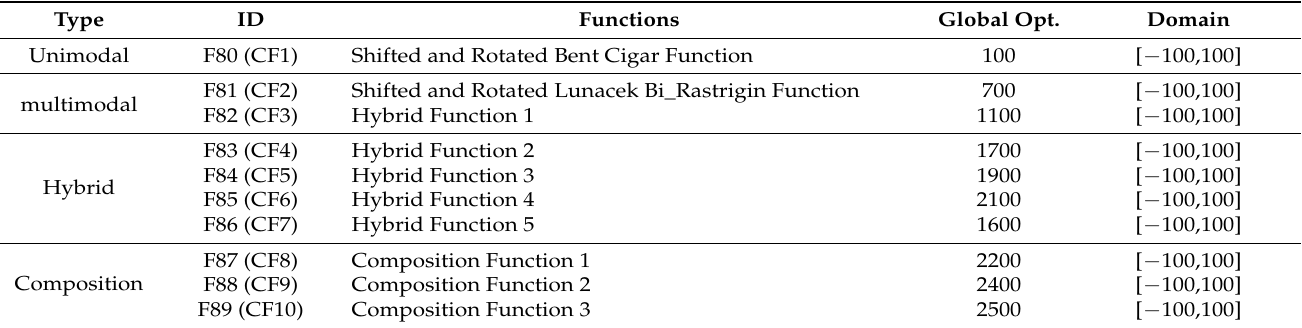
Table A6. Description of CEC2020 benchmarks.